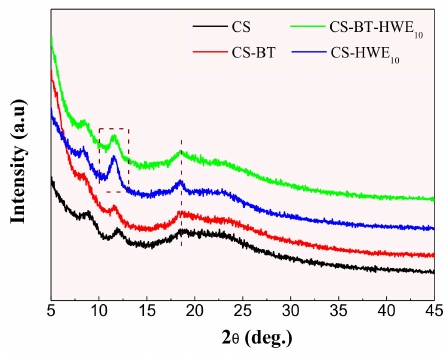
Figure 6. X-ray di ff raction patterns of composite films prepared from chitosan, BT, and hot water wood extract.